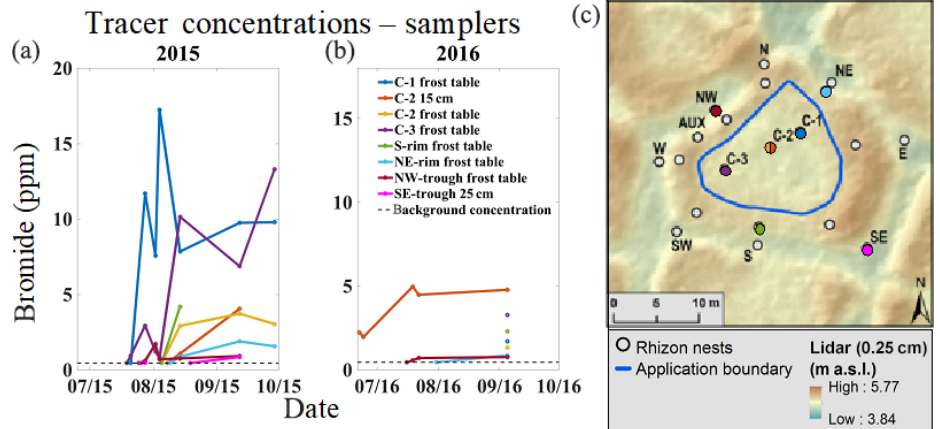
Figure 9. Tracer breakthrough curves for the low-centered polygon (a) and dots representing their corresponding locations (c) . The color of the dots correspond to the breakthrough curve of the same color. The blue line on the polygon digital elevation model (c) depicts the area of tracer